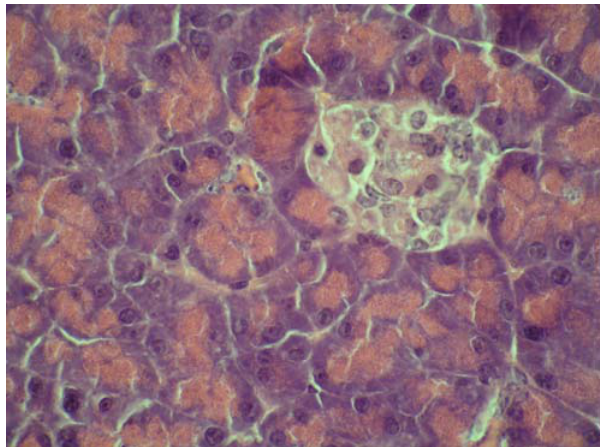
Figure 4. Microphotograph of the pancreas – the effect of mimulone ( 2 ) on the pancreatic histopathology of diabetic mice (HE 600×). Regressive changes to pancreatic islet